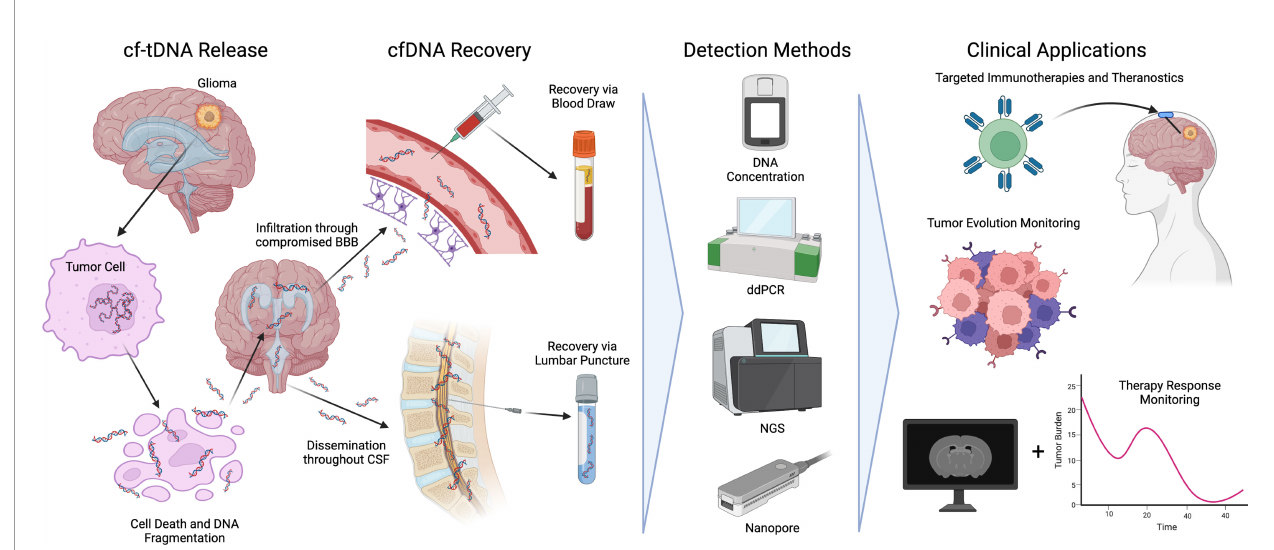
FIGURE 1 | An overview of cf-tDNA release into bio fl uids, recovery, detection methods, and current clinical applications bene fi ting immunotherapies for